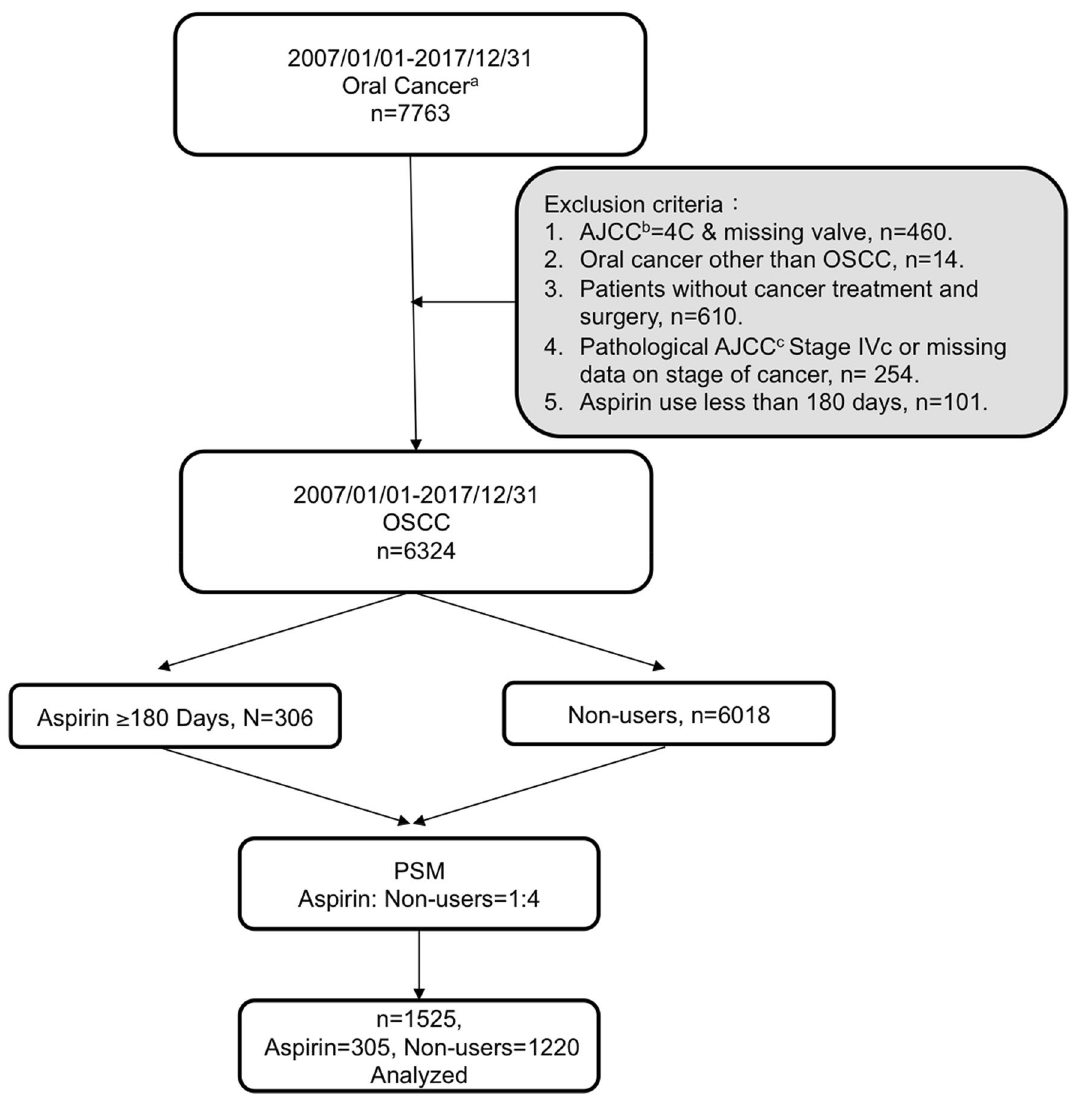
Figure 1. Flowchart showing the inclusion and exclusion criteria of the OSCC patients recruited to engage in this cohort study. A total of 7,763 patients who were diagnosed with oral cancer were recruited in this study. After matching aspirin users with non-users based on 1:4 propensity score analysis, there was a final inclusion of 1,525 OSCC patients were recruited for data analysis in this study. a Clinical and Pathological AJCC Cancer Staging 7th Edition; b Clinical AJCC Cancer Staging 7th Edition; c Pathological AJCC Cancer Staging 7th